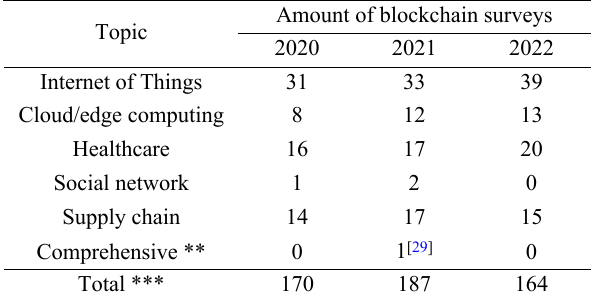
Table 2 Amount of blockchain surveys on related